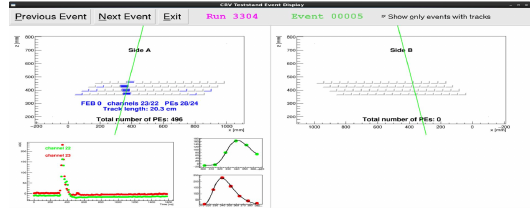
Figure 12. Example of event display at the Cosmic Ray test stand used to qualify CRV modules.